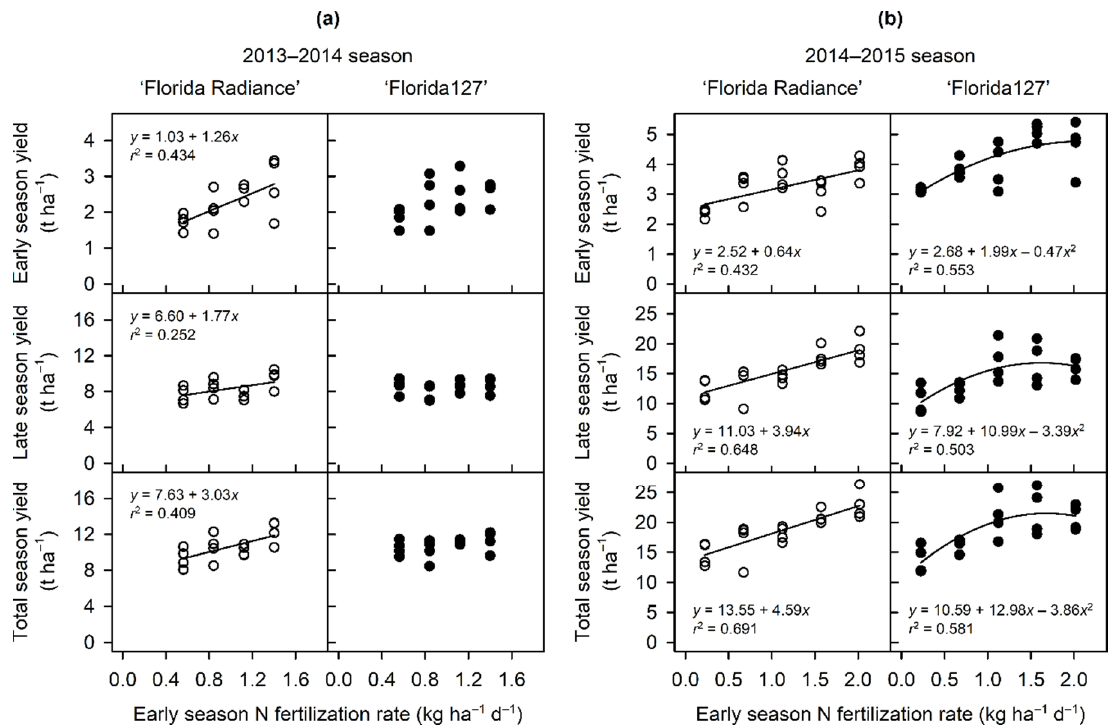
Figure 2. Marketable yield responses of two strawberry cultivars to different early-season nitrogen (N) fertilization rates: ( a ) 2013–2014 growing season ( b ) 2014–2015 growing season. Treatments are as described in Tables 1 and 2. Five models were fit to each data set: linear, quadratic, exponential plateau, exponential decay, and sigmoidal models. Only the significant ( p ≤ 0.05) and best-fit model is shown for each data set. No regression line is shown when none of the models had a significant fit. Early season = November–December. Late season = January–February.